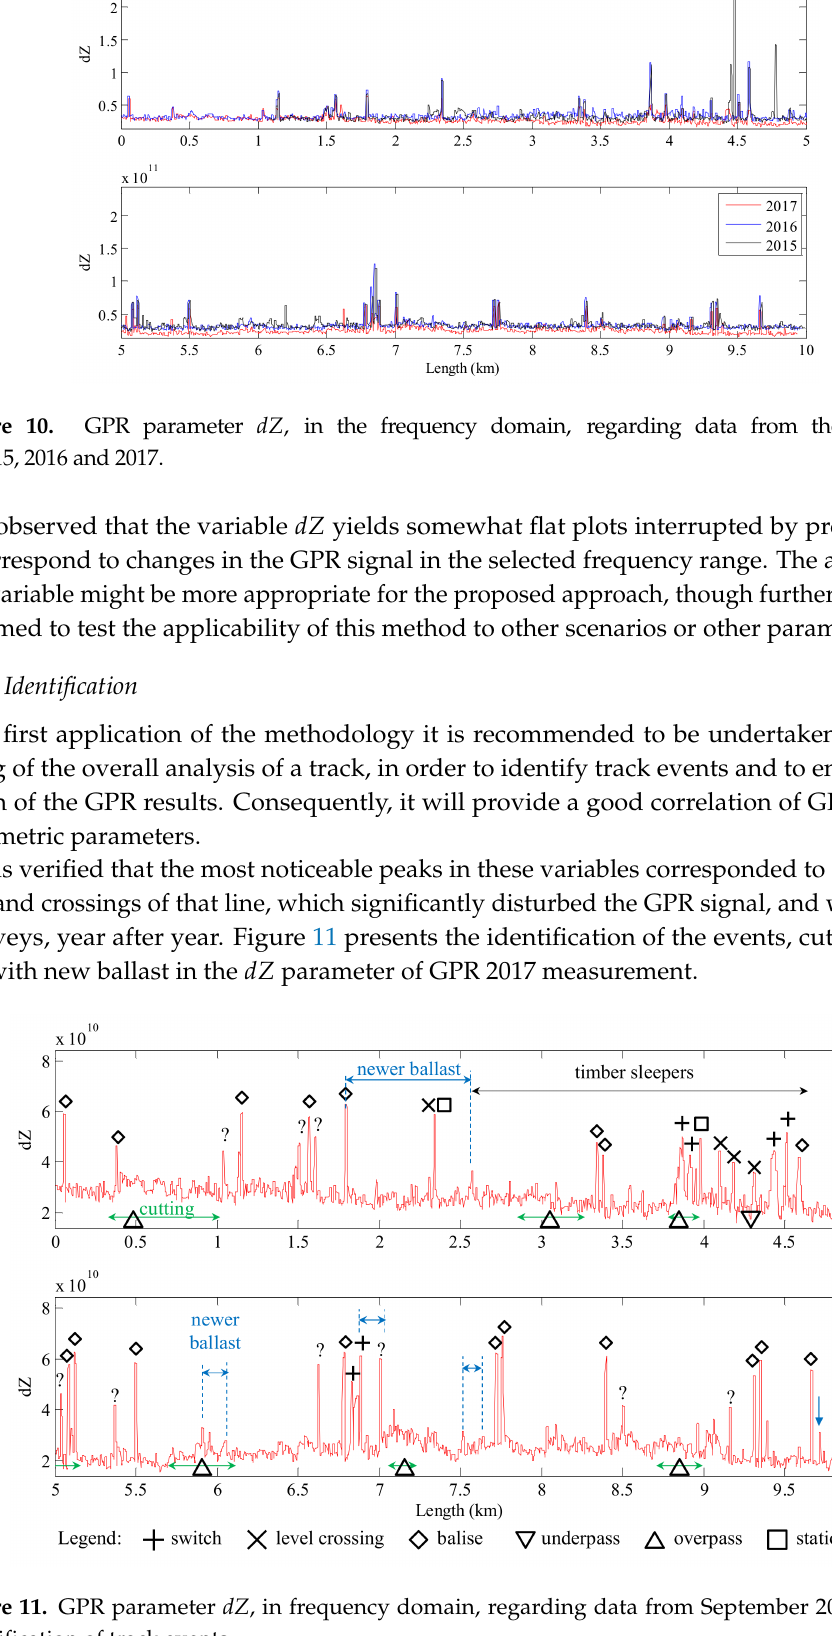
Figure 11. GPR parameter dZ , in frequency domain, regarding data from September 2017 and the identification of track